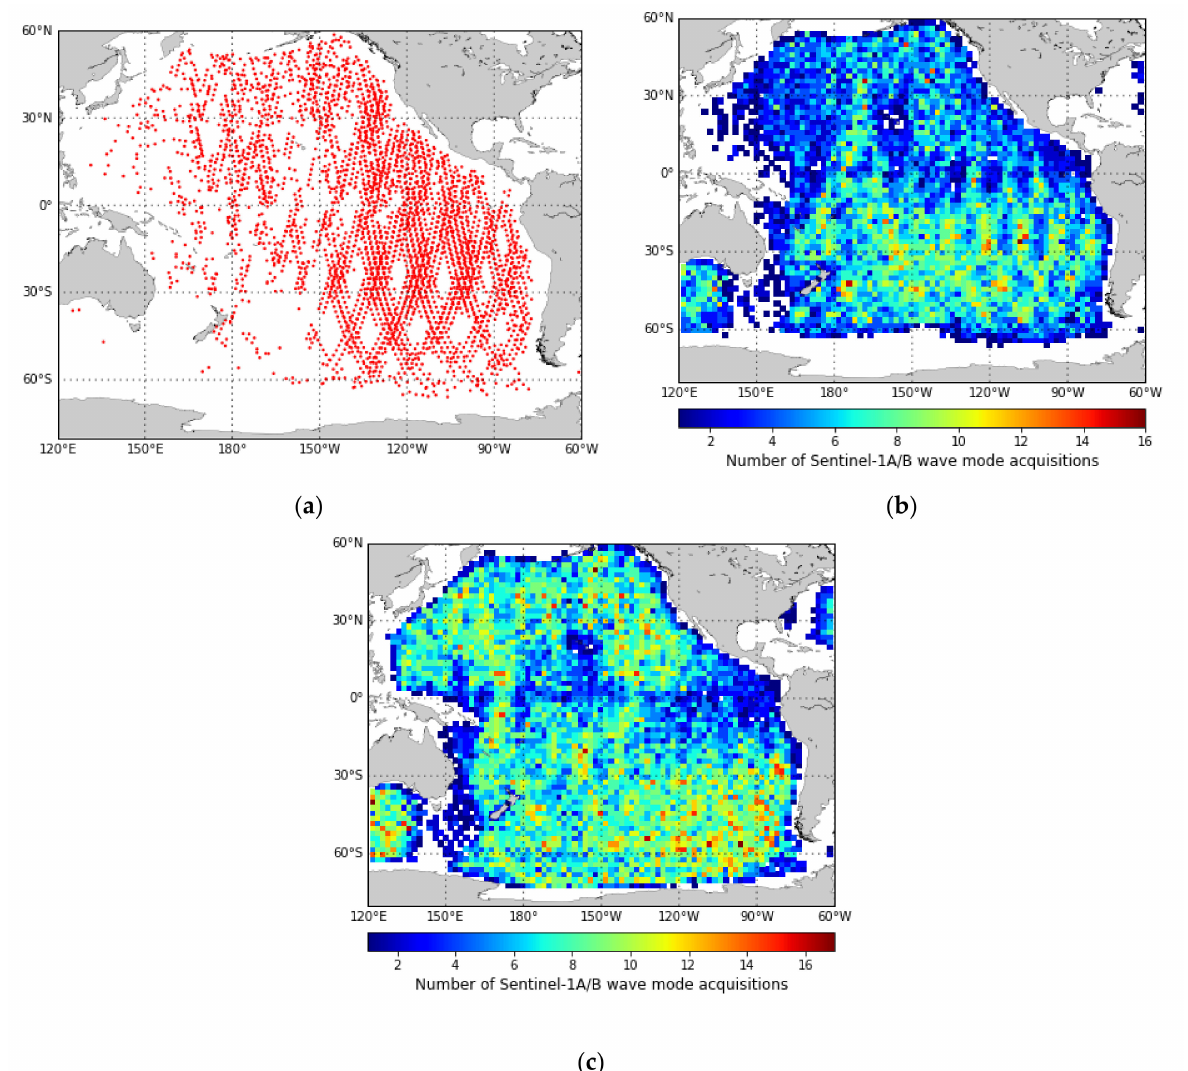
Figure 5. Distribution of Sentinel-1A/B wave mode acquisitions over the period from 29 July 29 to 11 August 2016. ( a ) Data associated to the swell event illustrated in Figure 3. ( b ) Data associated to other swell events. ( c ) Data failed to converge to any